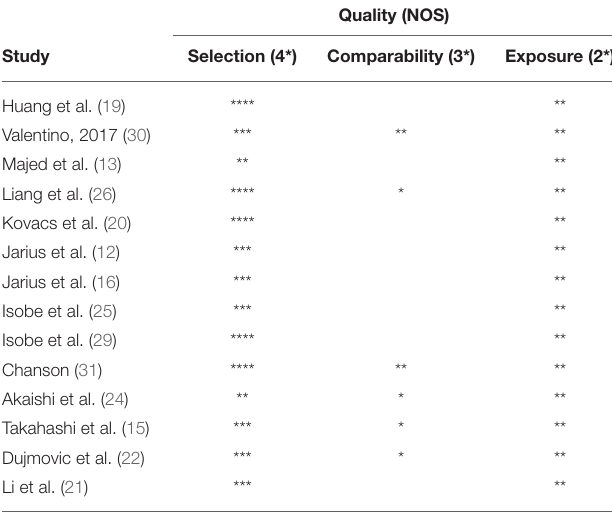
TABLE 4 | Quality evaluation of the included studies for the